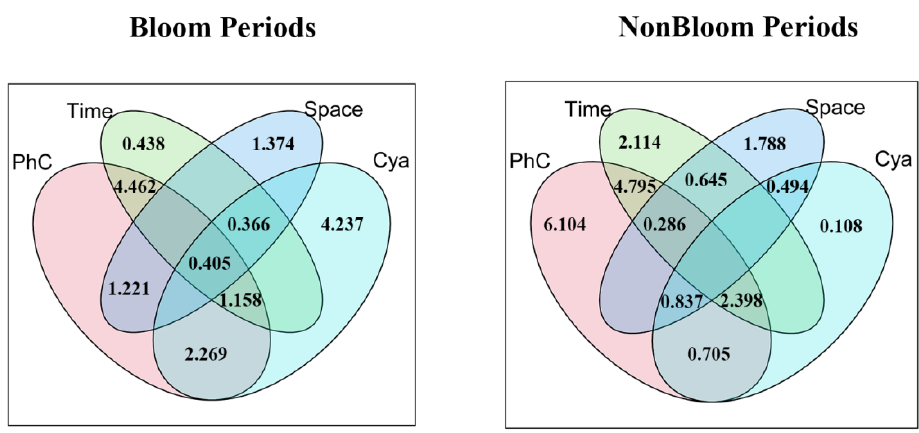
Figure 5. Percentages of the total explained variance by physicochemical (PhC), temporal (Time), spatial (Space), and cyanobacterial (Cya) for metazooplankton communities in LXK and LXX.